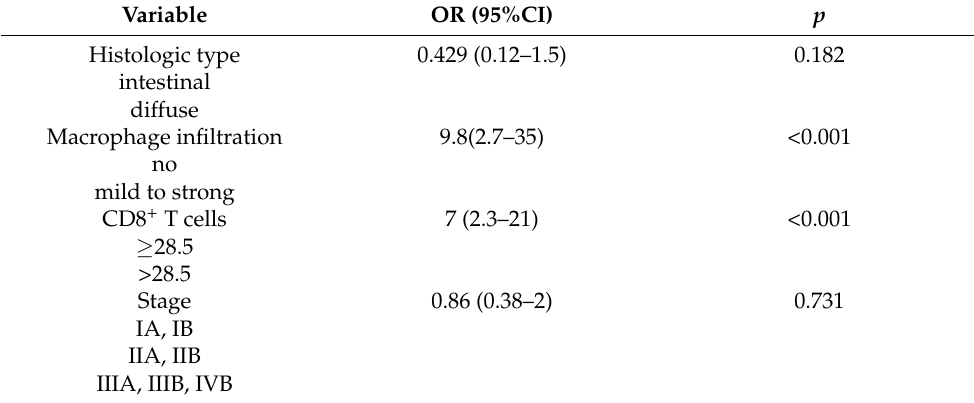
Table 3. Multivariate analysis of variables associated with PD-L1 status of